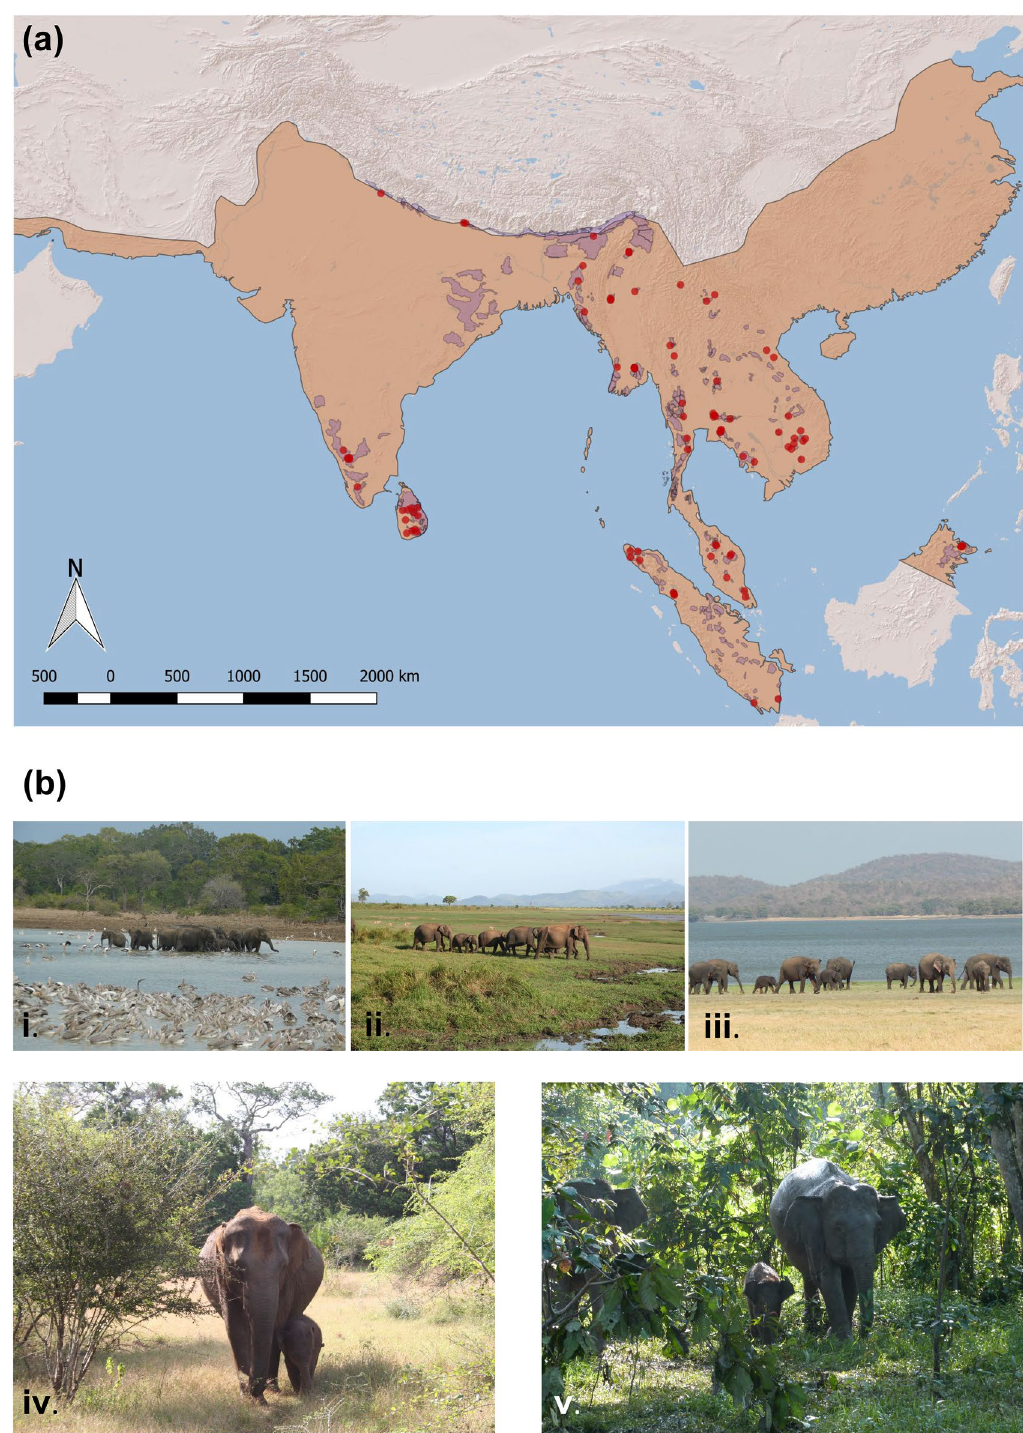
Figure 1. Locations of elephant occurrence. ( a ) Brown shaded region shows presumed historic post-glacial range (Olivier 20 ), smaller purple polygons show current range (classified as “active confirmed” in Hedges et al. 85 ), points show sampled occurrences. Map created by S. de Silva in Quantum GIS (QGIS, https:// www. qgis. org) v.2.18.25. ( b ) Examples of Asian elephant ecosystems. Upper panel: anthropogenic water sources of varying ages and scale at which elephants gather in Sri Lanka. ( i ) A small reservoir originally built and maintained at village-level with inhabitants resettled in the 1980s after the creation of Udawalawe National Park, now maintained by wildlife managers. ( ii ) A large dammed reservoir completed in the 1970s and maintained by the national government, the impetus for creation of Udawalawe National Park. ( iii ) The large Minneriya reservoir built by King Mahasen in the third century and restored in the 1800s following British occupation. Small reservoirs provide year-round water whereas large reservoirs also yield floodplain vegetation for forage. Lower panel: Asian elephants occur in dry seasonally deciduous forests ( iv ) as well as lush a-seasonal rainforests. Photos: S. de